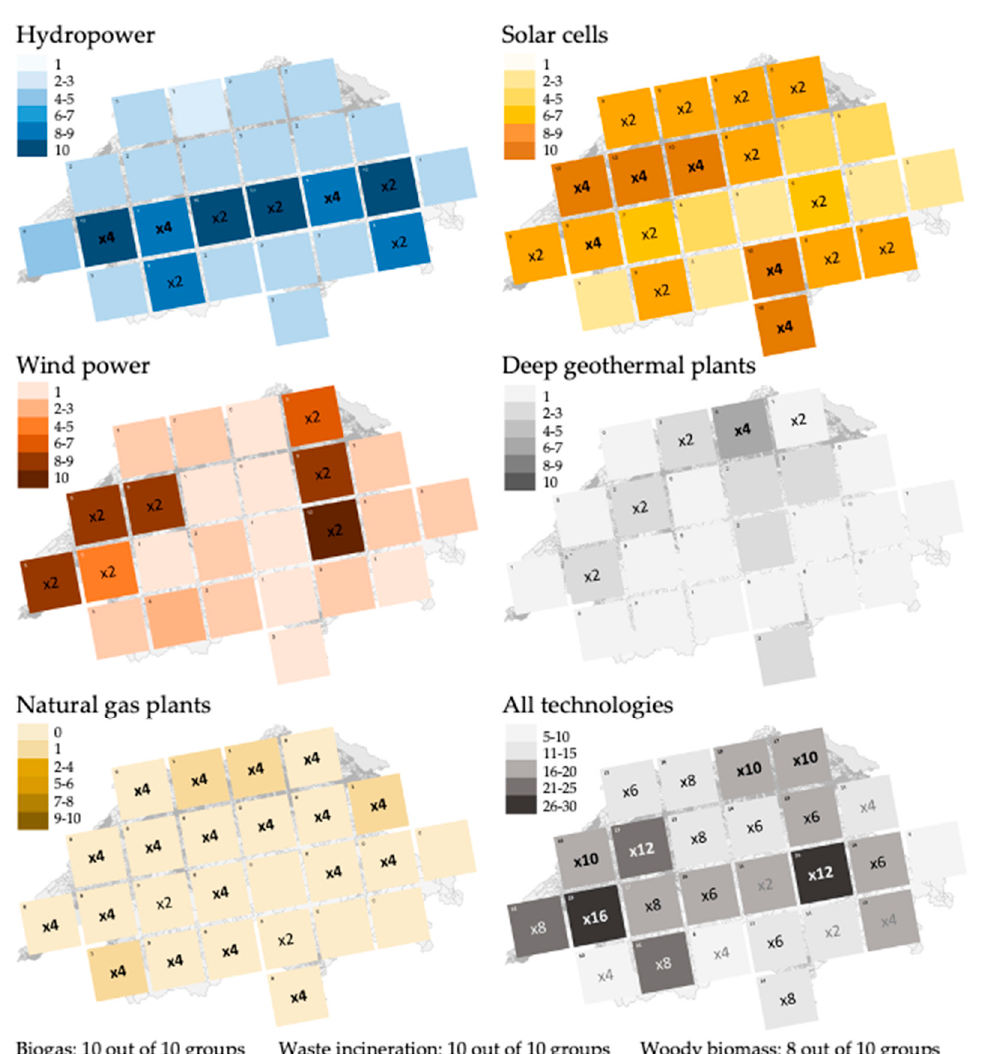
Figure 3. Summary of the technology choice and location at the end of all 10 serious board games with 44 participants in total. The color of the boxes represents the number of foils placed by all participants in each box. The annotations “ × 2” and “ × 4” mark the boxes, where one foil would respectively earn two or four points and hence would indicate boxes with higher efficiency or productivity.